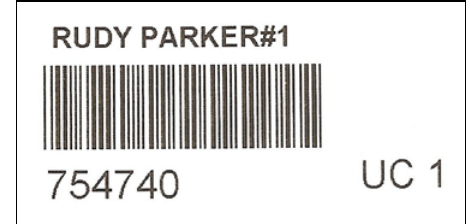
Figure 12-2. Example of a urine collection bar-code